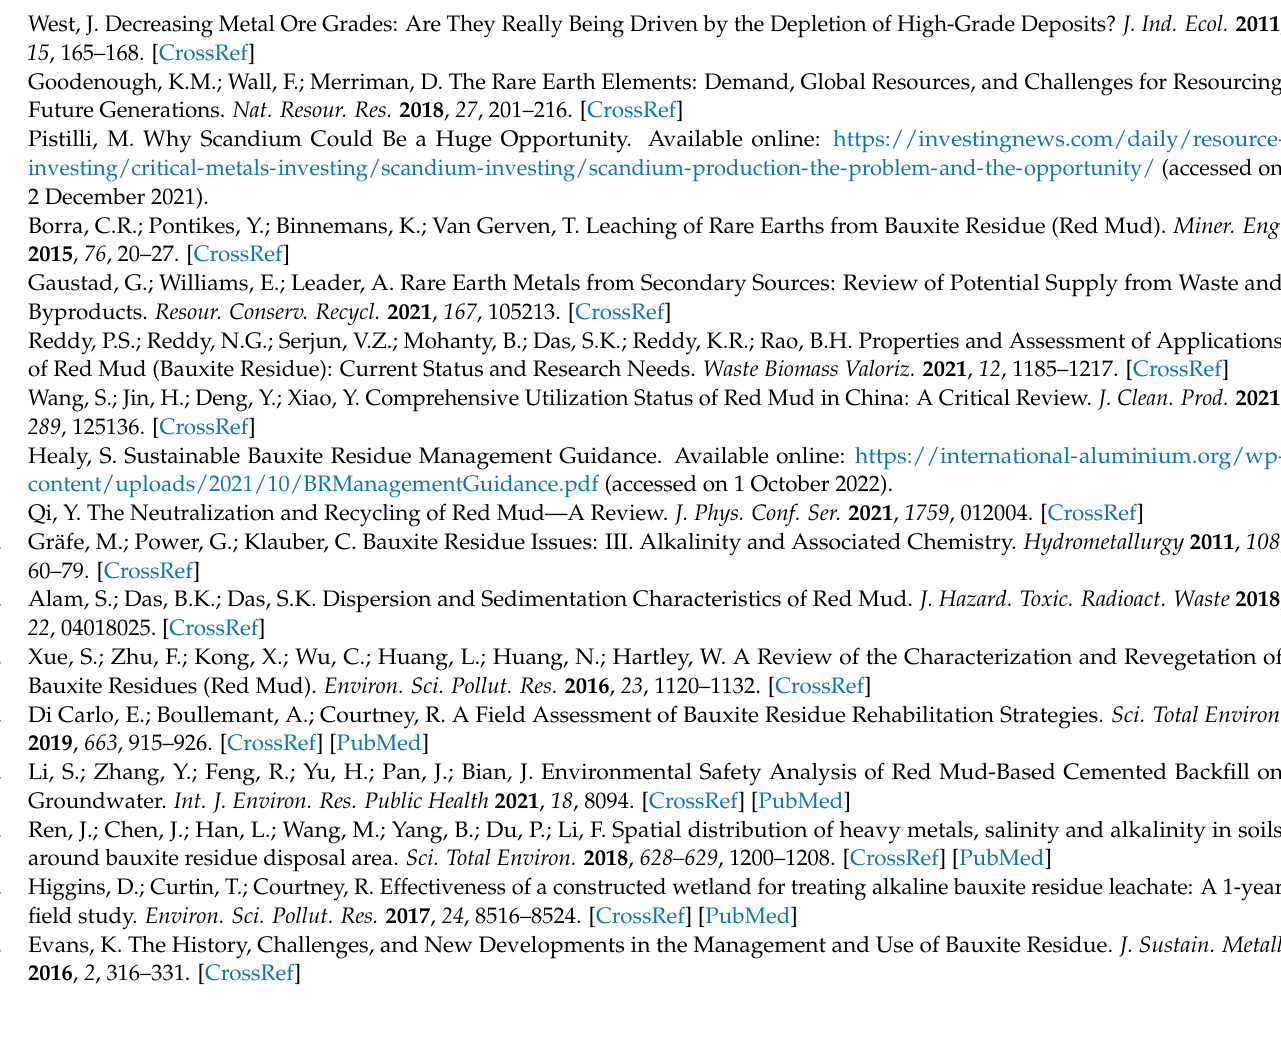
Figure A3. Adsorption isotherms of N 2 at 77 K for impure alumina obtained at the conditions of Figure 8c ( a ) and for white carbon before and after water leaching ( b ).